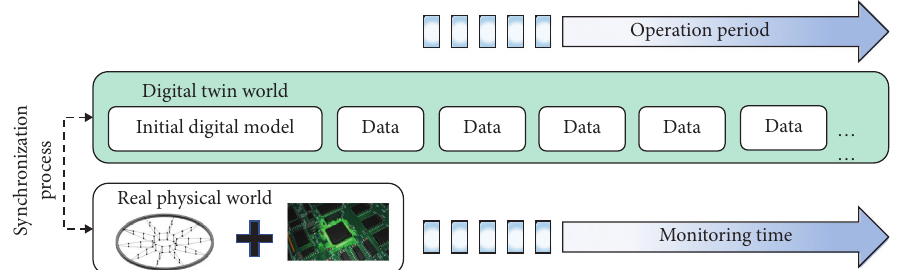
Figure 2: The realization of digital